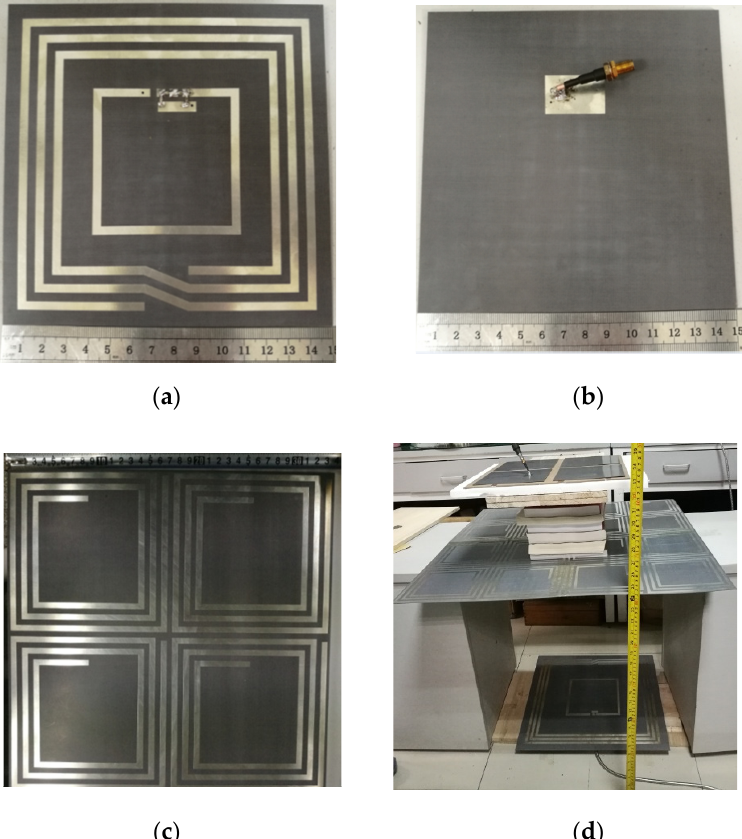
Figure 12. ( a ) The front view of the Tx coil. ( b ) The back view of the Tx coils. ( c ) The permeability metasurface, and ( d ) the measurement setup.